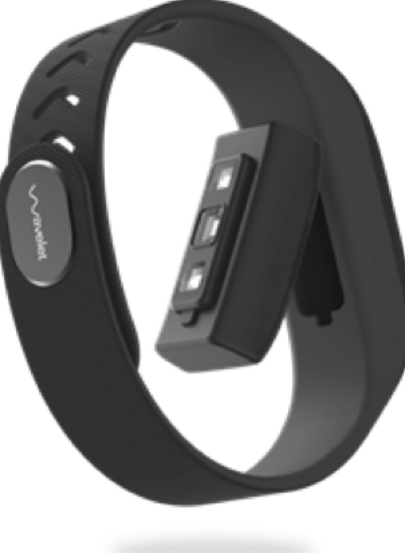
Figure 2. The Wavelet wristband is a configurable photoplethysmography and motion sensing device placed on the wrist to collect pulse wave signal, estimate vital signs, and physical activity. The sensor carriage can be removed from the plastic